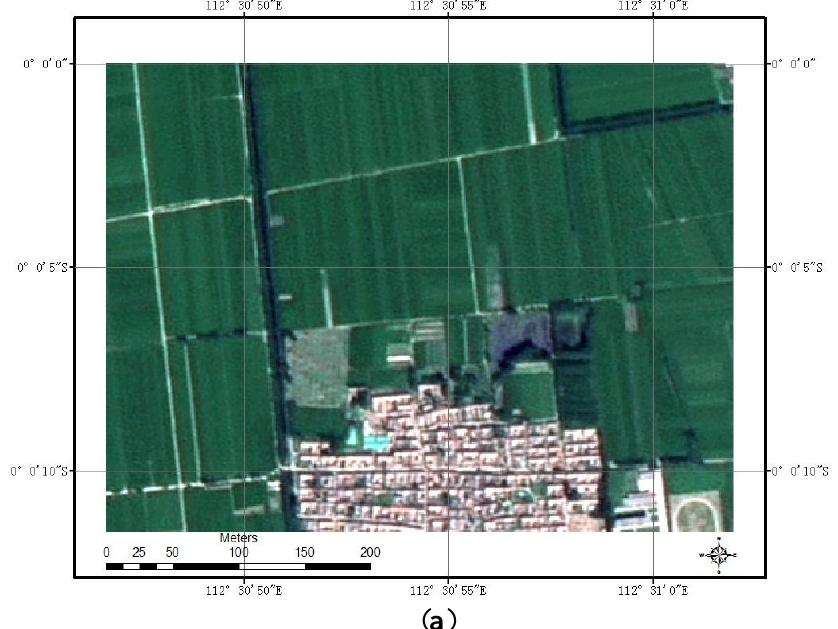
, image acquired in 1